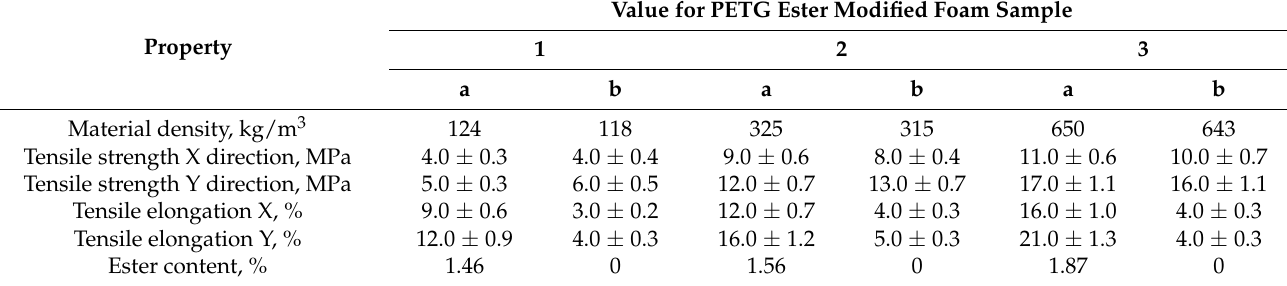
Table 4. Typical properties of PETG foam.